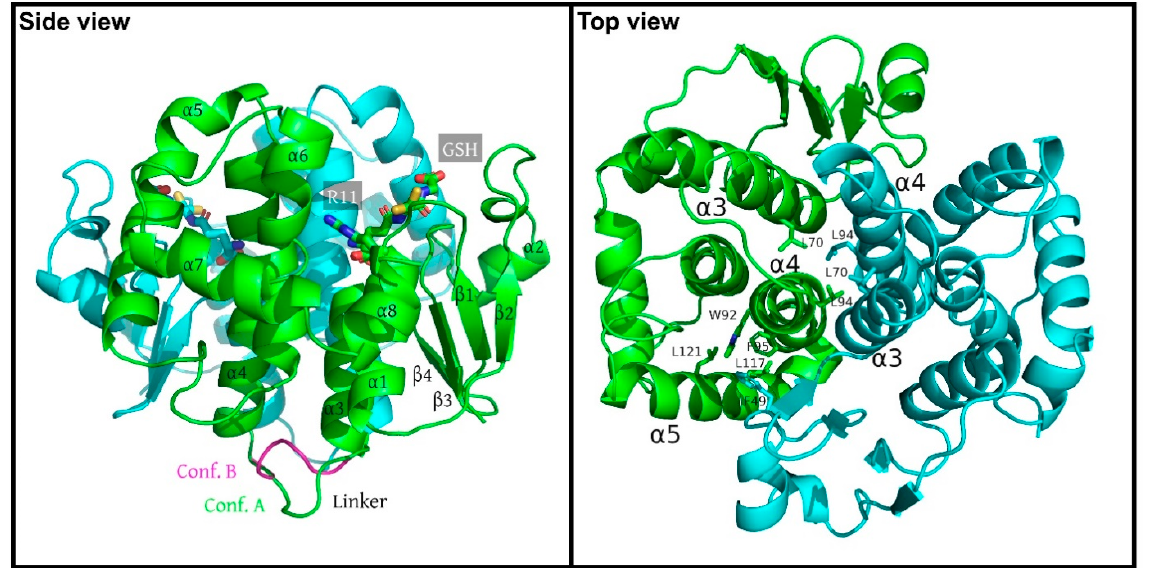
Figure 1. Crystal structure of the SynGSTC1 dimer, left, and rotated 90°, right. The monomers A and B are shown in ribbon mode and colored green and blue, respectively. ( Left ), side view. The secondary structures of the monomer A are labelled. In each monomer, the side chain of residue R11 and the glutathione molecules are labelled and highlighted as sticks. Both conformations of the linker are shown in monomer A. ( Right ), top view. The figure highlights the hydrophobic patches on SynGSTC1 dimer interface. L70 and L94 of both monomers are buried in the center of the dimer. This interaction pattern is complemented by a lock-and-key motif where the F49 residue (blue) fits into a low-polar cavity of the adjacent subunit (W92, F95, L117, L121) (green). The symmetry related lock-and-key motif is not shown for clarity.